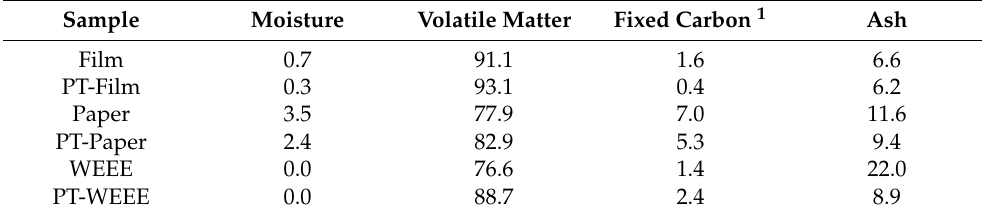
Table 4. Proximate analysis of raw and pre-treated waste samples (wt.%, as received).